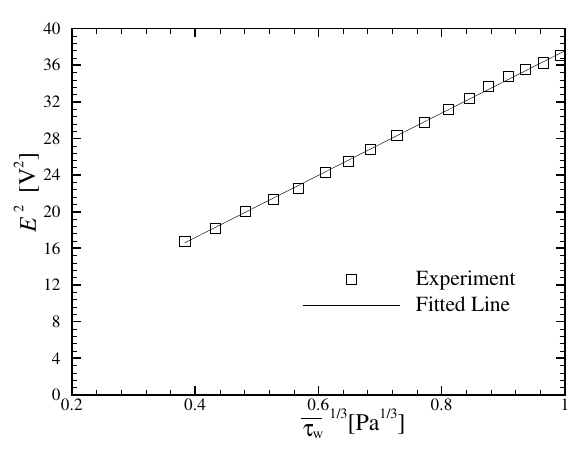
Fig. 15 Static response of HF sensor at x / d = 30 ( (cid:28) w 1 3 versus E 2